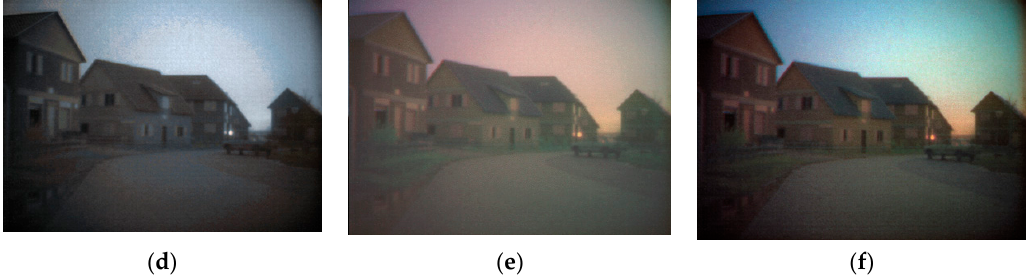
Figure 13. Results from color transformations derived from the standard training set applied to a different scene with different sensor settings, registered in the same environment: ( a ) CTN method;